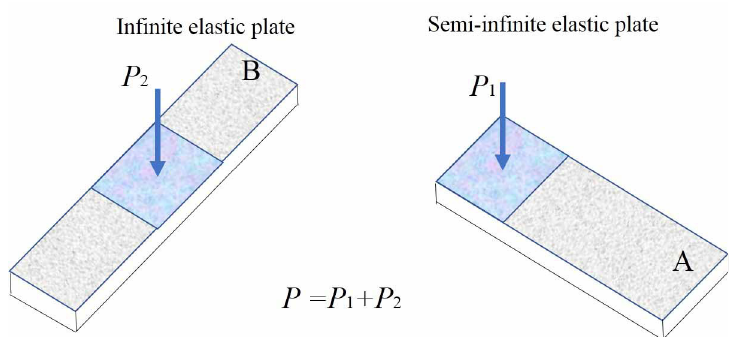
Figure 3. Approximation of ice